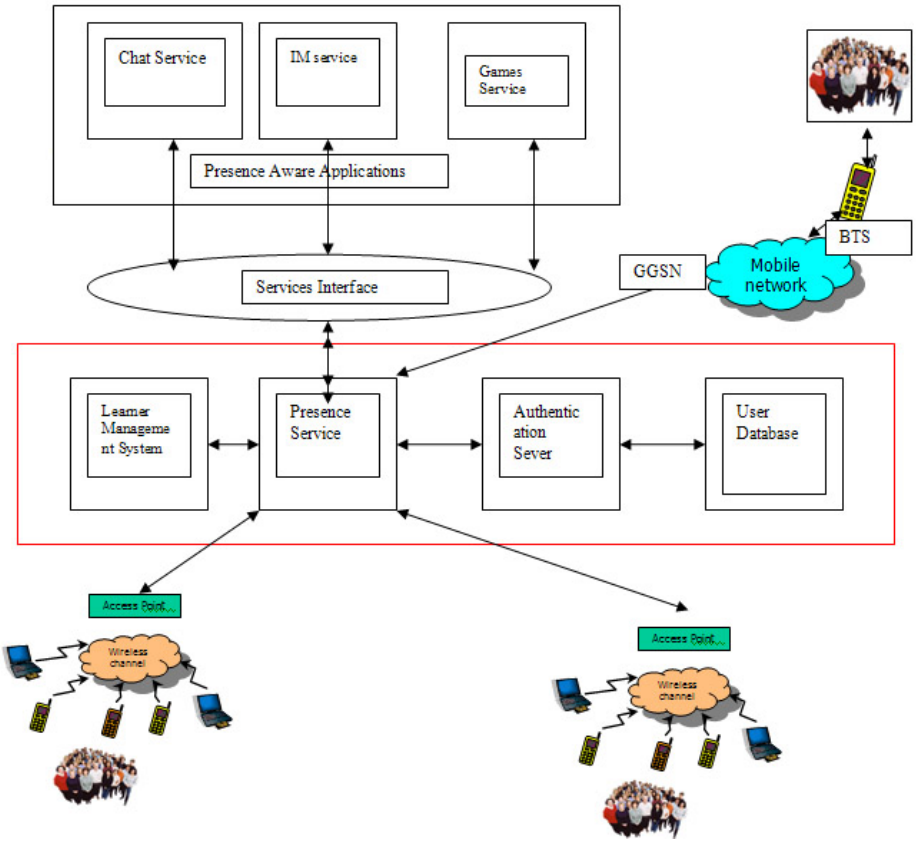
Figure 1. An example of IM system